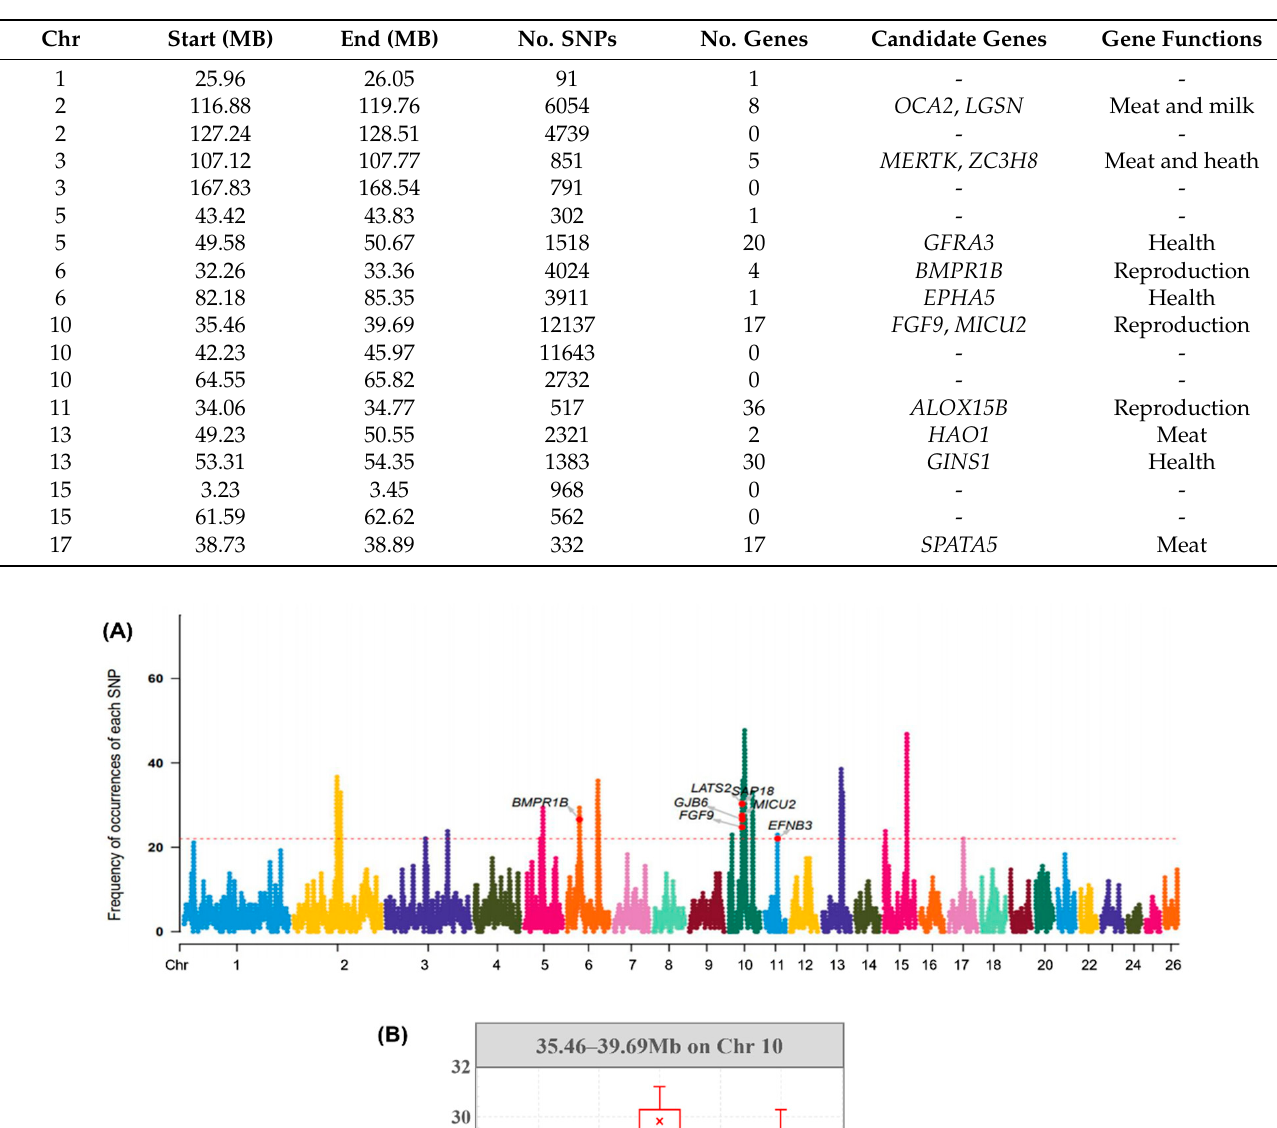
Table 4. List of ROH islands observed in the Hu sheep population.